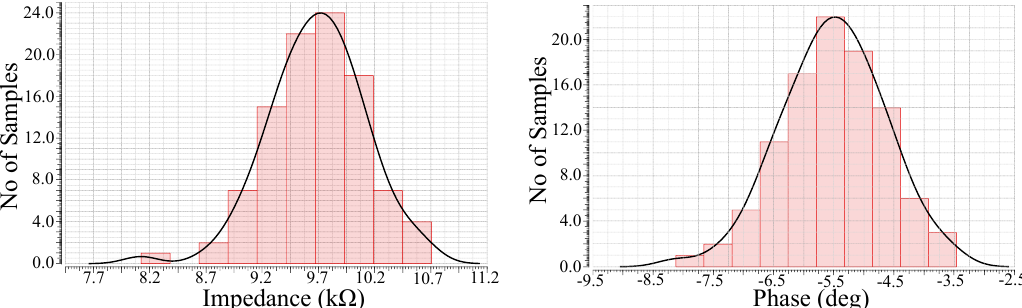
Figure 35. Sensitivity performance of magnitude for target impedance R b = 10 k Ω using Monte-Carlo analysis (versatile design).